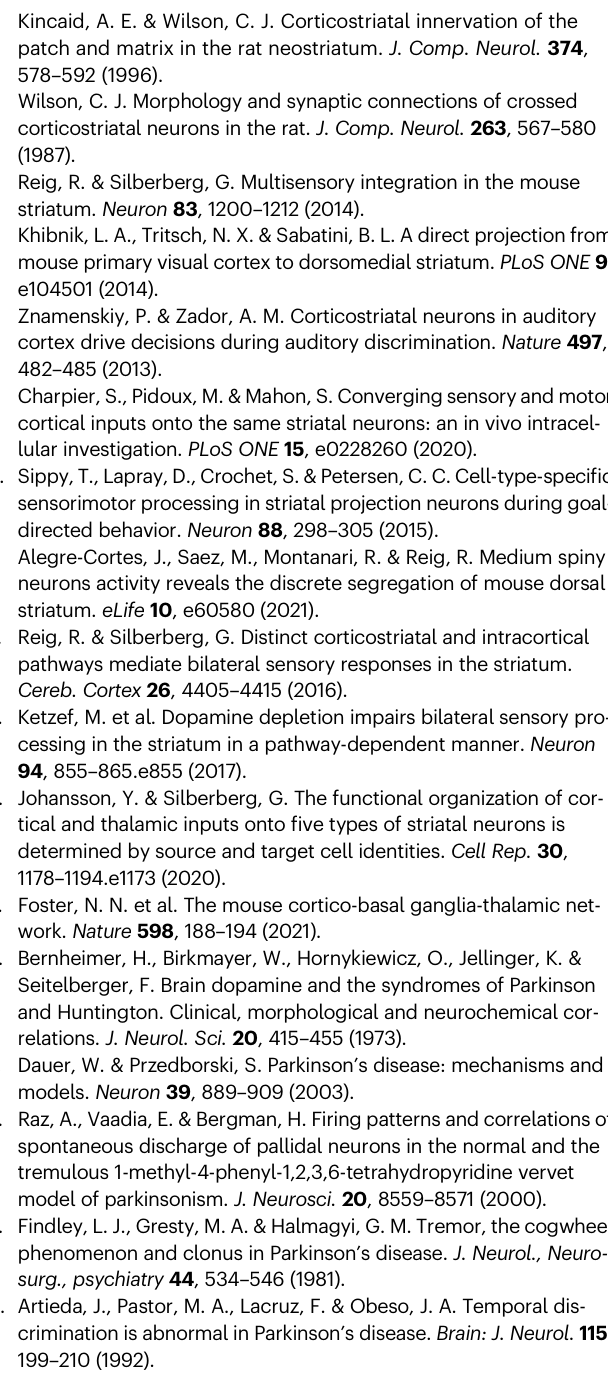
Fig.7|Thelatecomponentofthesensoryresponseisnotinvolvedinlaterality encoding and is reduced in dMSNs following DA depletion. a Schematic of contralateral(contra) and ipsilateral(ipsi) whiskerde fl ections during quiet epochs incontroland6-OHDAlesionedmice.Thestimulationsweredeliveredrandomlyin intervals from 3 to 6s. b Grand average of the late component of the sensory response of dMSNs in control (left) and 6-OHDA (right) lesioned mice to con- tralateral (dark blue traces) and ipsilateral (light blue traces) whisker stimulation. The light blue rectangle indicates the late component of the response to sensory stimulation.Thegraybarindicatesthemomentthestimulationwasdelivered. c No differences in response amplitude, onset delay or area under the curve (AUC) of dMSNs responses to contralateral (C) and ipsilateral (I) stimulations in control or 6-OHDA lesionedmice. Note the diminution inresponse amplitude (dMSNcontrol C=3.85±0.73mV; dMSN 6-OHDA C=2.06±0.45mV, two-sided Mann-unpaired t